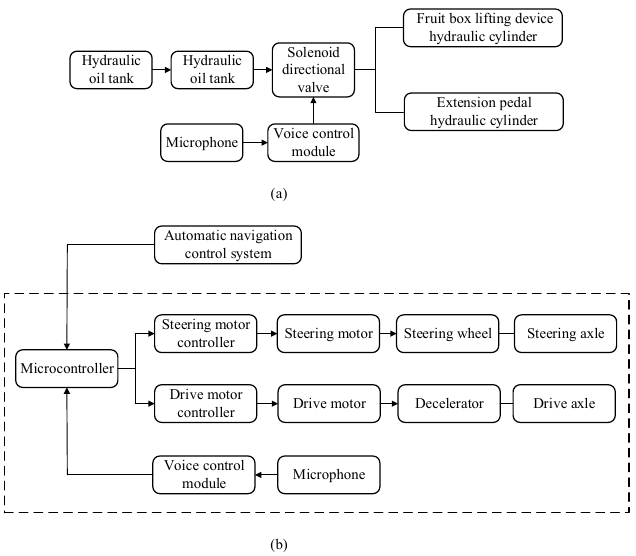
Figure 10. Structural composition of the voice control system. ( a ) Structural composition diagram of the operation voice control system. ( b ) Structural composition diagram of the walking voice con- trol